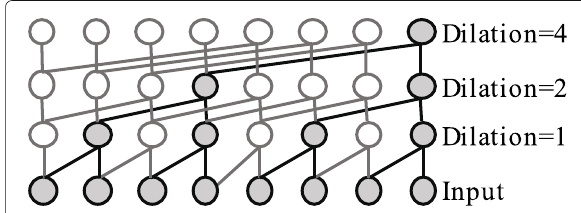
Fig. 3 A stack of dilated causal convolution